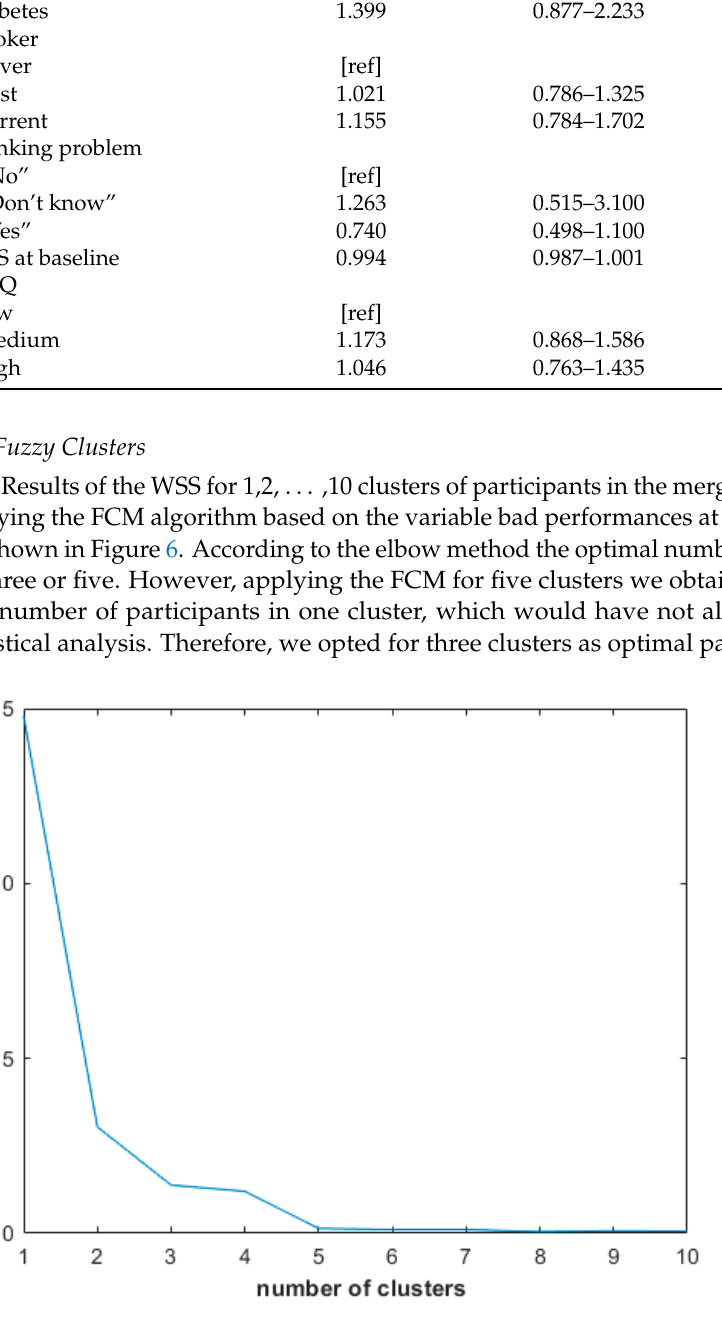
Figure 6. Elbow method applied to the merged cohort ( N = 3468) showing the Within-Clusters-Sum of Squared errors (WSS) for 1,2,…,10 clusters.